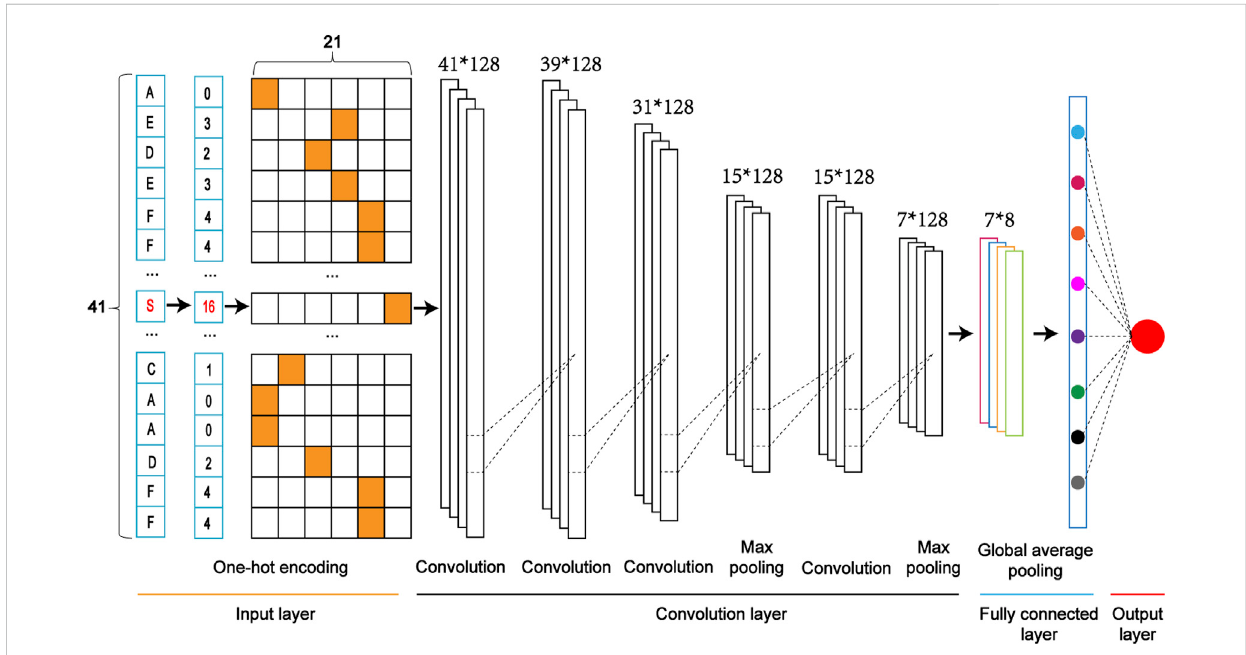
FIGURE 3 The architecture of a one-dimensional convolutional neural network with the One-Hot encoding approach (i.e., CNN OH ).